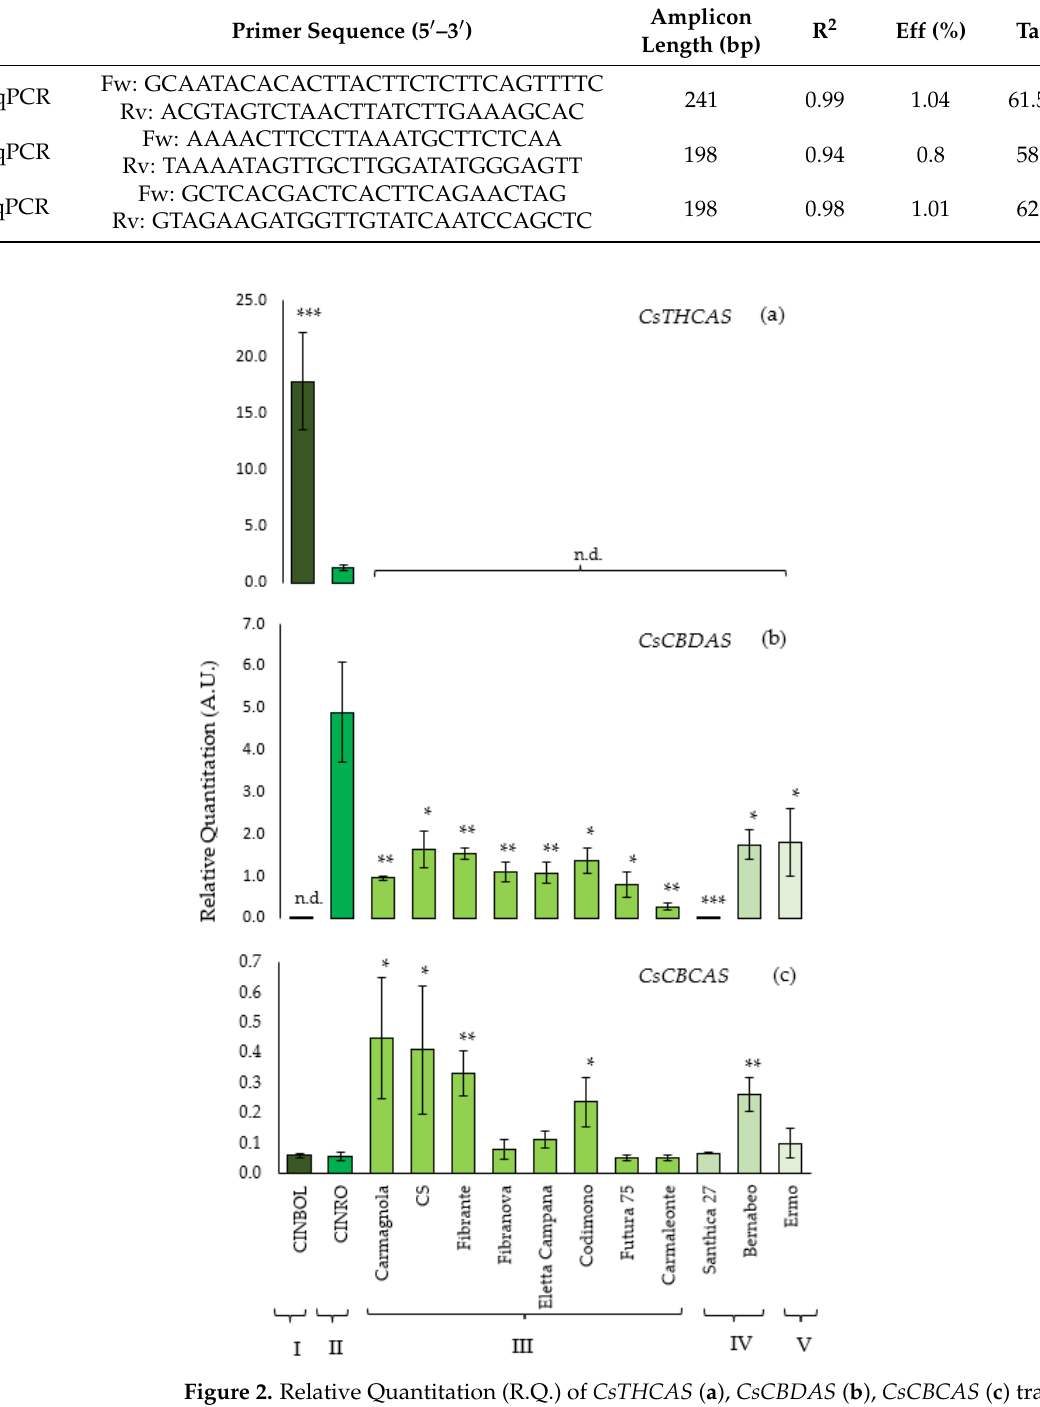
Table 3. List of primer pairs used for RT-qPCR. Forward (Fw) and reverse (Rv) primer sequences, amplicon length expressed in base pairs (bp), regression coefficient (R 2 ), PCR efficiency (Eff), annealing temperature (Ta) and usage concentrations ( µ M) are given.